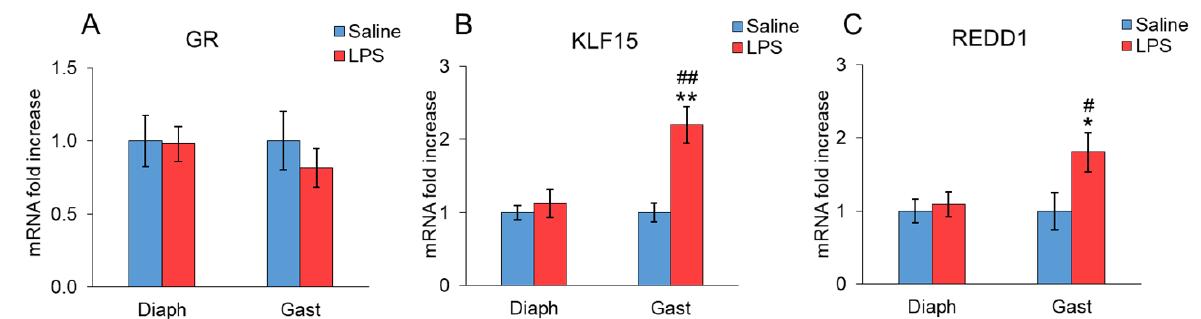
Figure 3. Effect of sepsis induced by LPS injection (10 mg/kg ip.) on ( A ) GR, ( B ) KLF15 and ( C ) REDD1 mRNA, in rat diaphragm and gastrocnemius muscles, 24 h after a single injection of LPS or saline solution. mRNA was measured by PCR. The data represent mean ± standard error of the mean (SEM) for n = 7–8 rats/group. * p < 0.05 and ** p < 0.01 versus their respective control rats treated with saline, # p < 0.05 and ## p < 0.01 versus diaphragm of rats treated with LPS. Diaph: diaphragm, Gast: gastrocnemius.